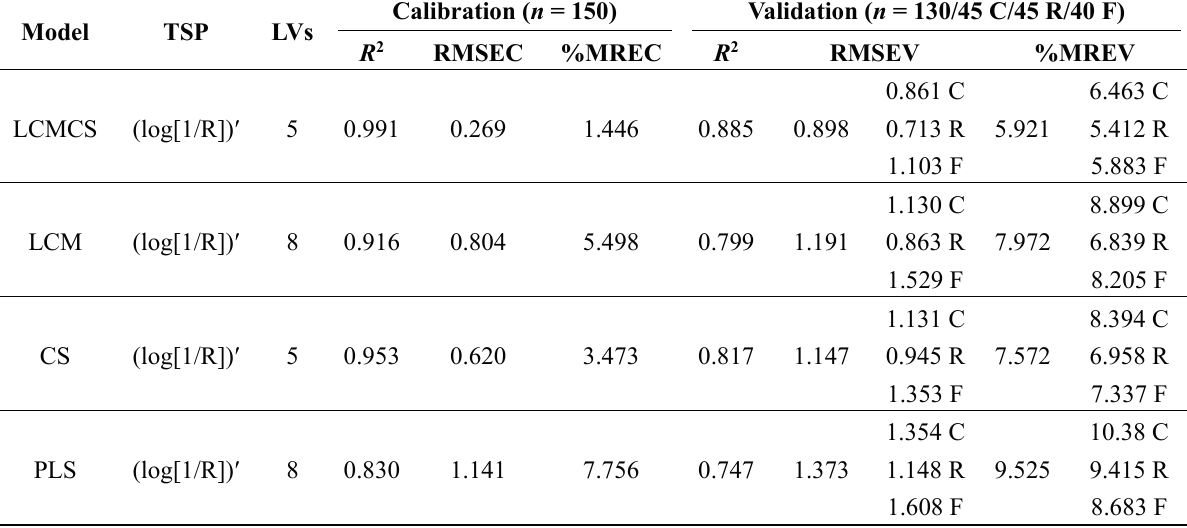
Table 7. Test result of the local correlation maximization-complementary superiority method (LCMCS), complementary superiority (CS), local correlation maximization (LCM) and partial least squares regression (PLS) models provides for total soil nitrogen (TN)